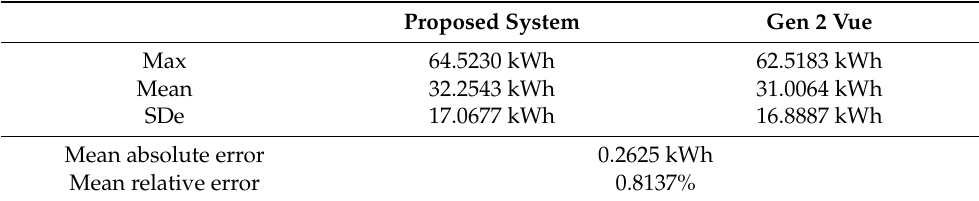
Table 10. Active energy data in line 1 obtained by both monitors.